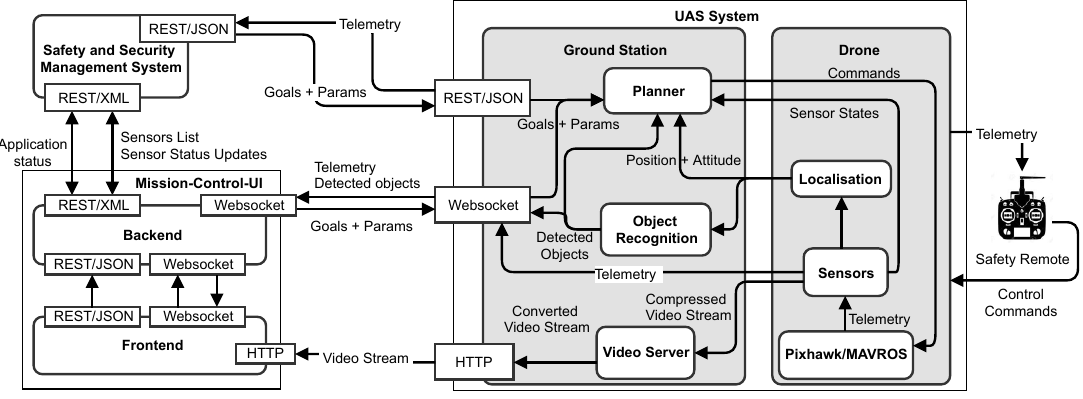
Figure 1. EffFeu system